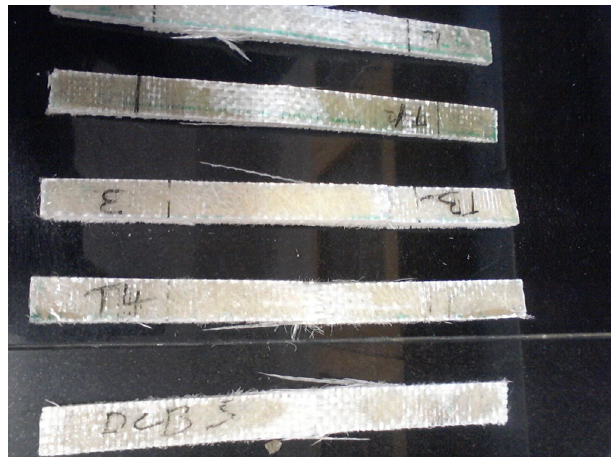
Figure 4. Tearing behaviour of the composite specimen under tension.